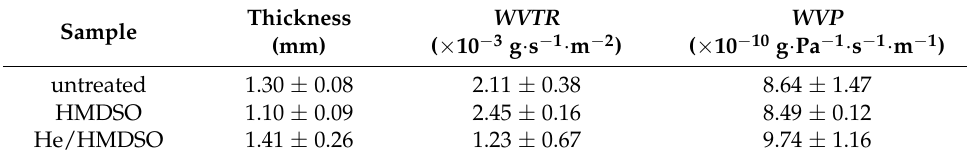
Table 1. Water vapor permeation of the untreated and treated starch films.